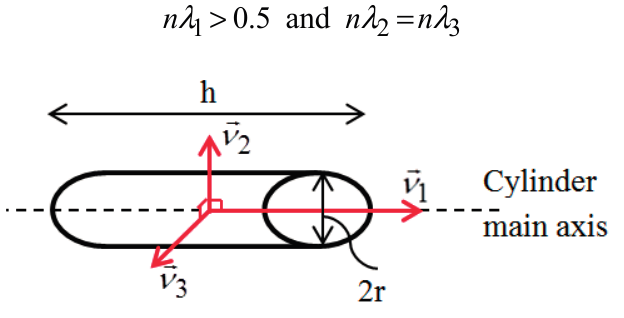
Figure 13. Eigenvectors within cylindrical neighborhood of bus pipes, considering rh >>